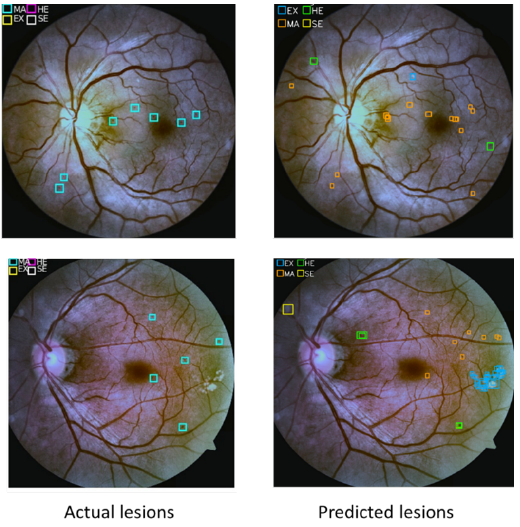
Figure 15. Samples of the miss labeled lesions from the DDR dataset compared to the predicted lesions by YOLOv3.